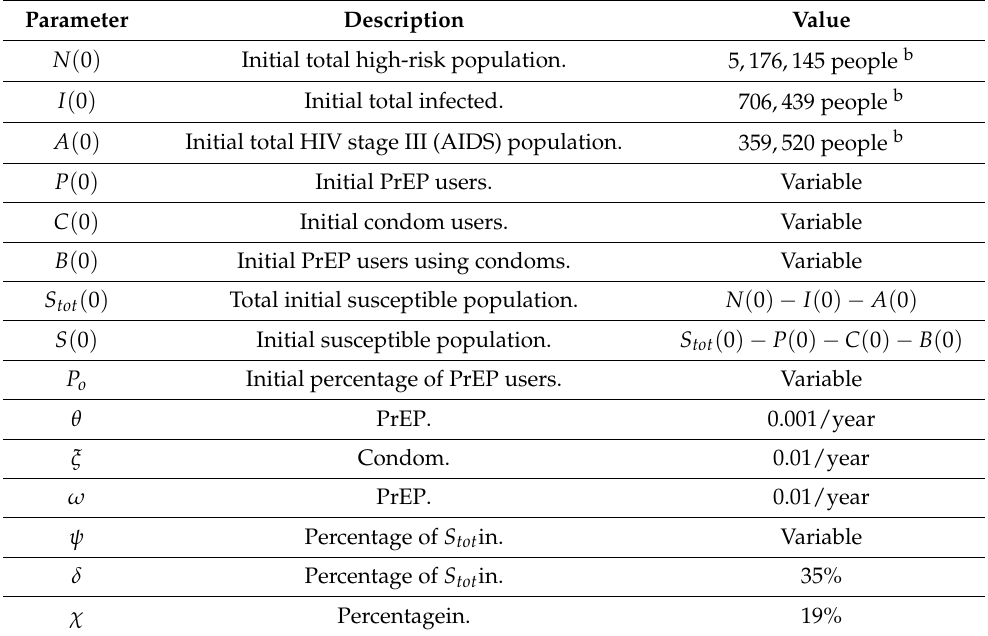
Table 3. List of SPCBIA model parameters a .